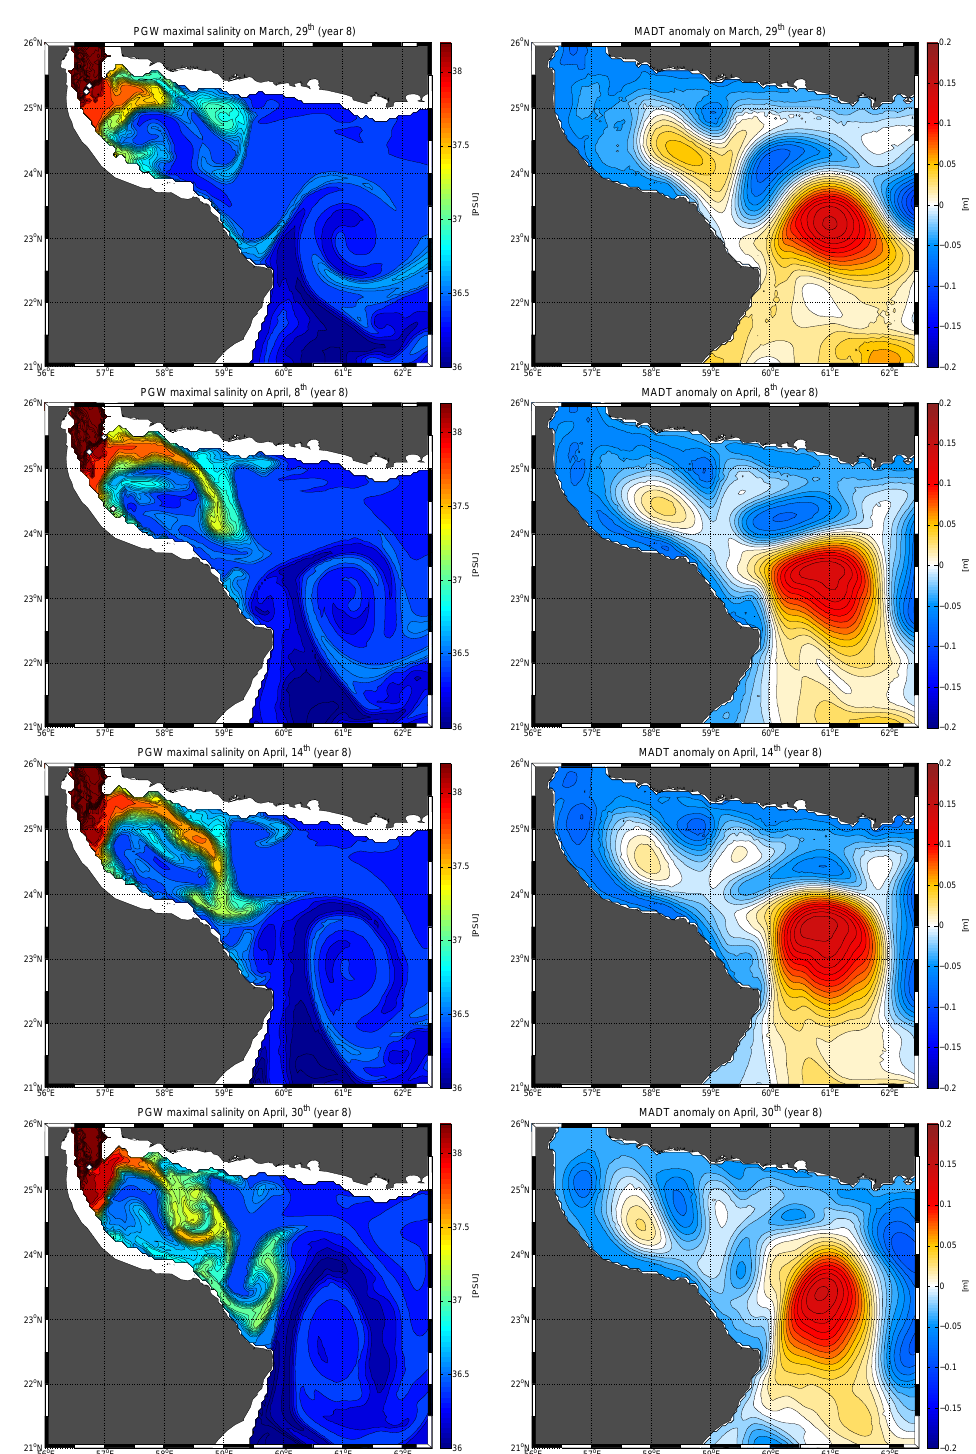
Figure 23. Evolution of the maximal PGW salinity (left) and MADT anomaly (right) during an ejection along the northern coast of the Sea of Oman in year 9 of the HYCOM simulation, on 29 March (first row), 8 April (second row), 14 April (third row) and 30 April (fourth row).